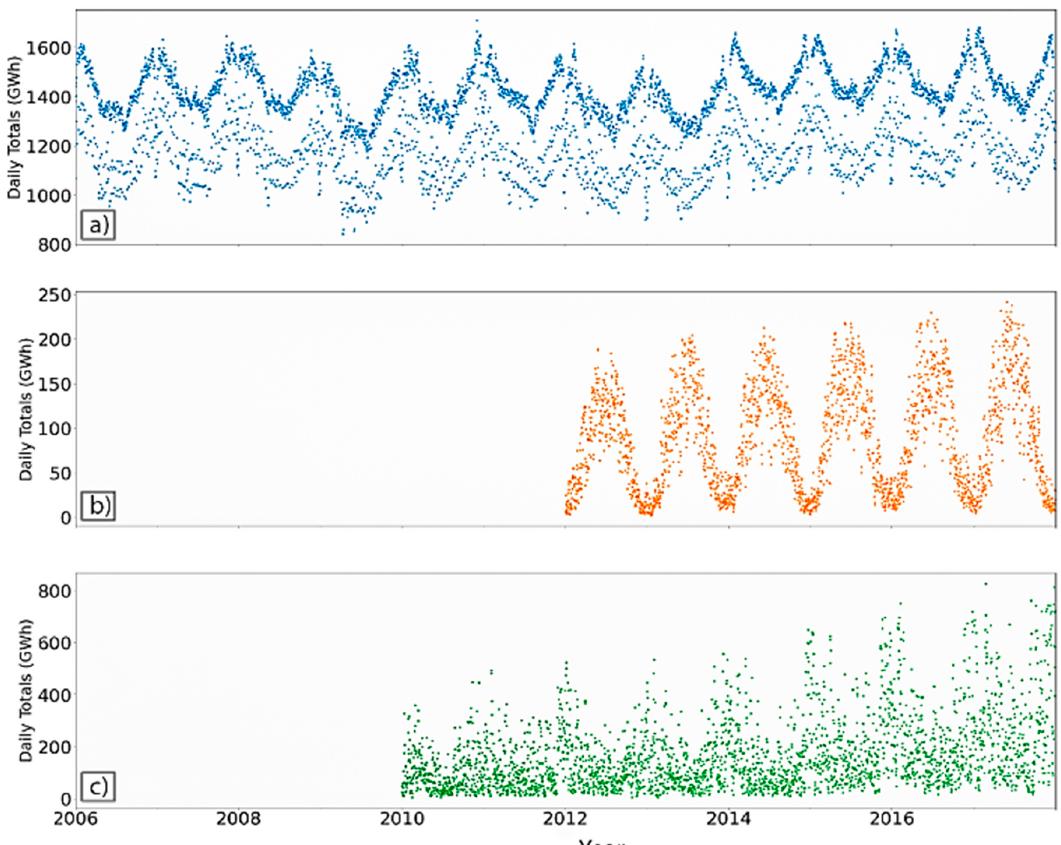
Figure 2. Line plots showing the temporal dynamics of the variables: ( a ) total energy consumption, ( b ) wind production, and ( c ) electricity production from 2006 to 2017.